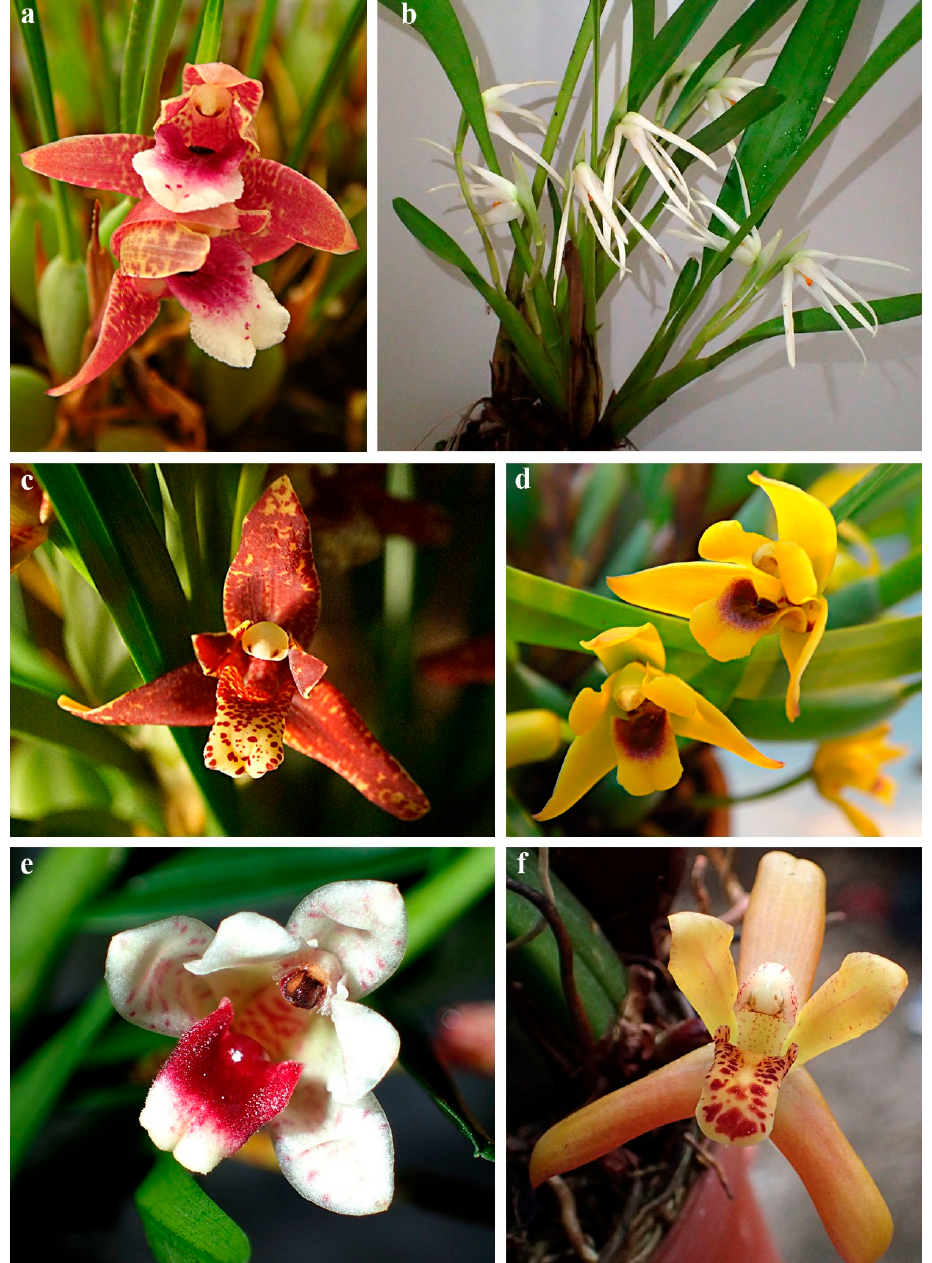
Figure 3. Flowers of Maxillariinae species examined to date: ( a ) Maxillariella sanguinea ; ( b ) Maxillaria splendens ; ( c ) Maxillariella tenuifolia ; ( d ) M. variabilis ; ( e ) M. vulcanica ; ( f ) Xanthoxerampellia rufescens . Photo. M. Lipi ń ska.